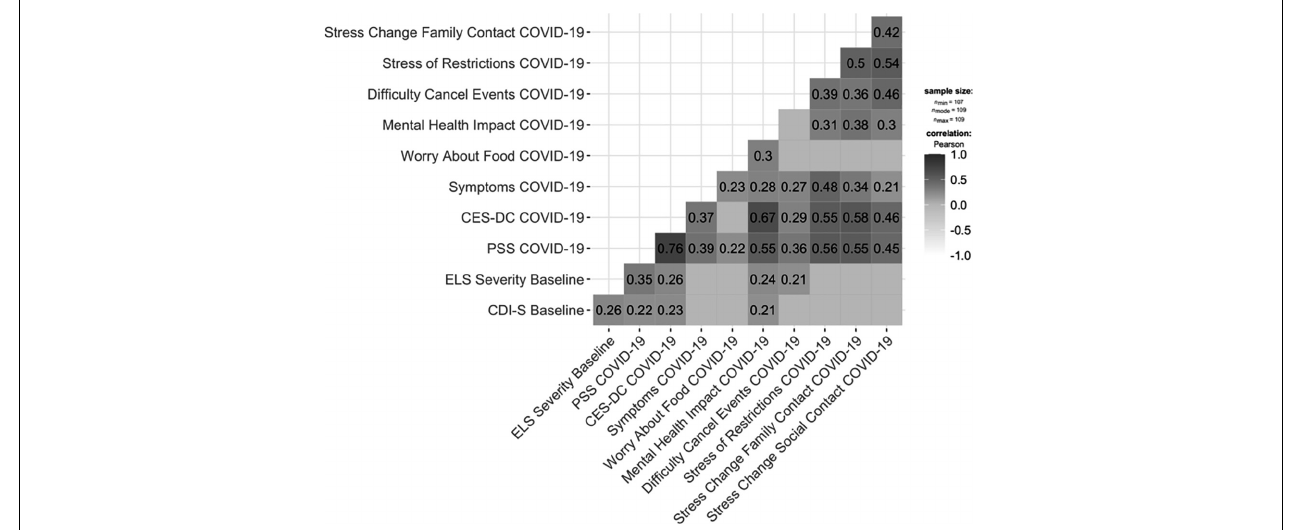
FIGURE 2 | Correlations among Baseline and COVID-19 items/measures assessed in this study. CDI-S, Children’s Depression Inventory; ELS Severity, early life stress; PSS, Perceived Stress Scale; CES-DC, Center for Epidemiologic Studies Depression Scale for Children. Content of COVID-19 items: Symptoms: self-reported fever, cough, shortness of breath, sore throat, fatigue, loss of taste or smell; Worry About Food: “did you worry whether your food would run out because of a lack of money?”; Mental Health Impact: “During the past two weeks, how worried have you been about your mental/emotional health being influenced by Coronavirus/COVID-19?”; Difficulty Cancel Events: “how much has cancellation of important events (such as graduation, prom, vacation, etc.) in your life been difficult for you in the past two weeks?”; Stress of Restrictions: “how stressful have the restrictions on leaving home been for you?”; Stress Change Social Contact: “how stressful have these changes in your social contacts been for you?”; Stress Change Family Contact: “how stressful have these changes in family contacts been for you?”. Correlations are corrected using False Discovery Rate; only significant correlations are shown.